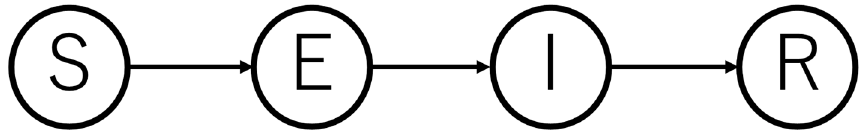
Figure 2. SEIR model flow chart .